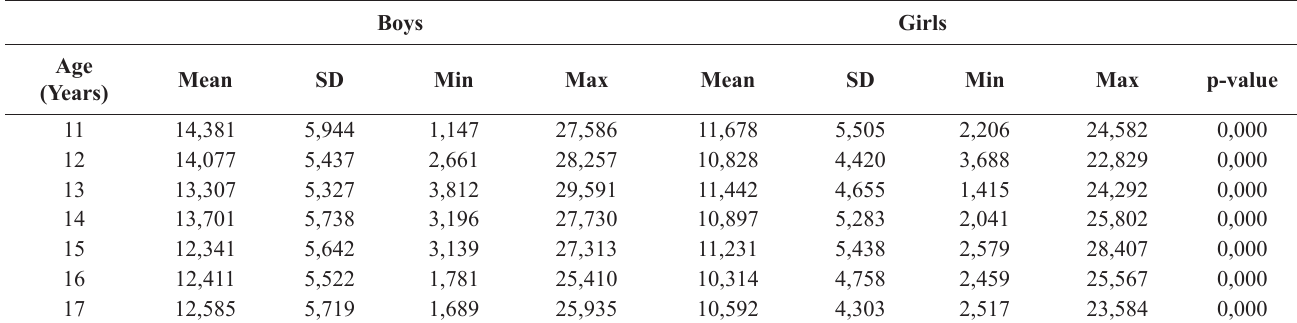
Table 2. Description of the number of steps/day by gender and age in adolescents of 11 to 17 years old in Uruguaiana, Rio Grande do Sul, Brazil, 2012.